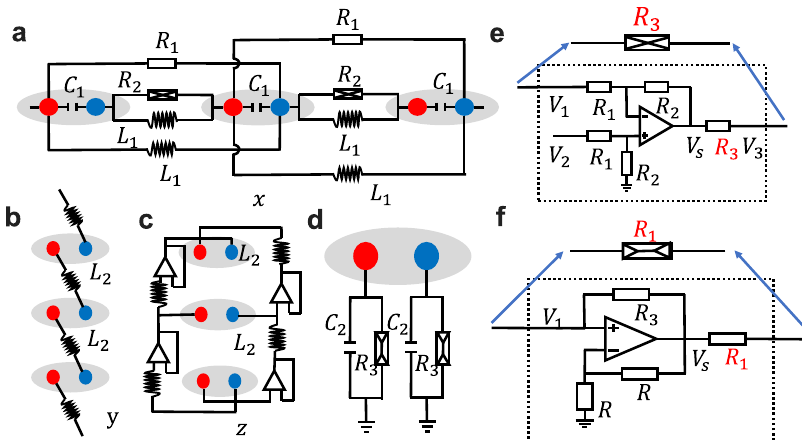
Fig. 5 Illustration of the various constituents of the Hopf link nodal knot metal (NKM) circuit. a – c Nearest-neighbor (NN) hopping in the ( a ) x direction, ( b ) y direction, ( c ) z direction. d Extra grounded (on-site) hopping to cancel the diagonal terms in the Laplacian. e , f Non-reciprocal feedback for skin (tidal) effects is implemented via ( e ) a differential ampli fi er and ( f ) a negative